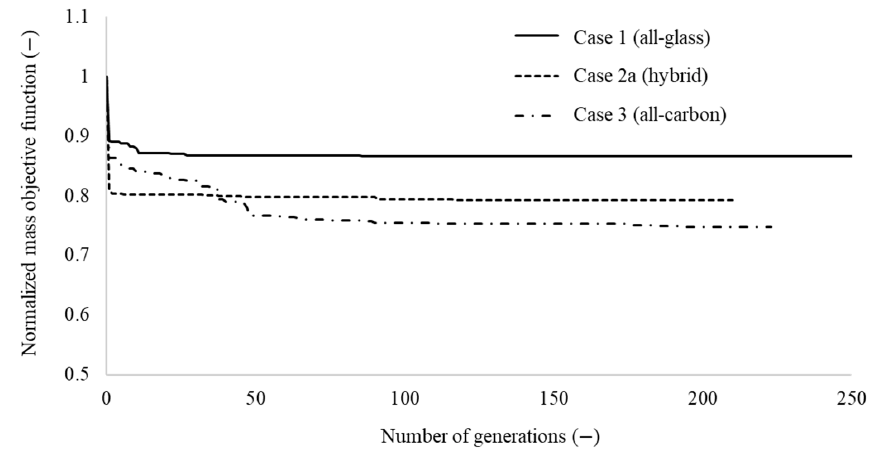
Figure 5. Convergence histories of the normalized blade mass optimization for DLC 6.2.